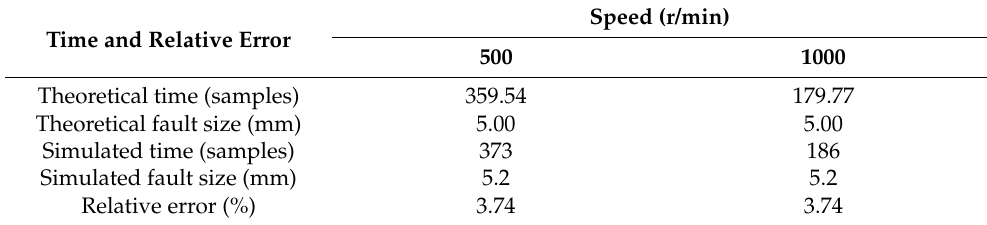
Table 2. Comparisons between the theoretical and simulated time of the double impulses.